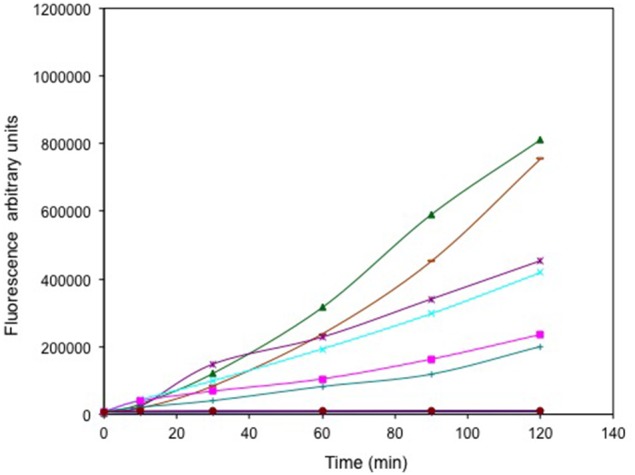
Time course of reactive oxygen species (ROS) production. Exponentially growing cells were washed, suspended in saline in the presence of the ROS sensitive probe carboxy-DCFH-DA and exposed to metals. 800 μg/mL selenite (green triangle), 16384 μg/mL selenate (purple *), 512 μg/mL arsenite (cyan X), 1 μg/mL tellurite (pink square), 128 μg/mL arsenite (green +), 13 μg/mL chromate (blue line) and 800 μg/mL vanadate (brown circles). ROS production in non-treated (blue solid diamond) and cells treated with H2O2 (brown dash) are presented as negative and positive controls respectively. The error bars represent the standard deviation between 3 trials.